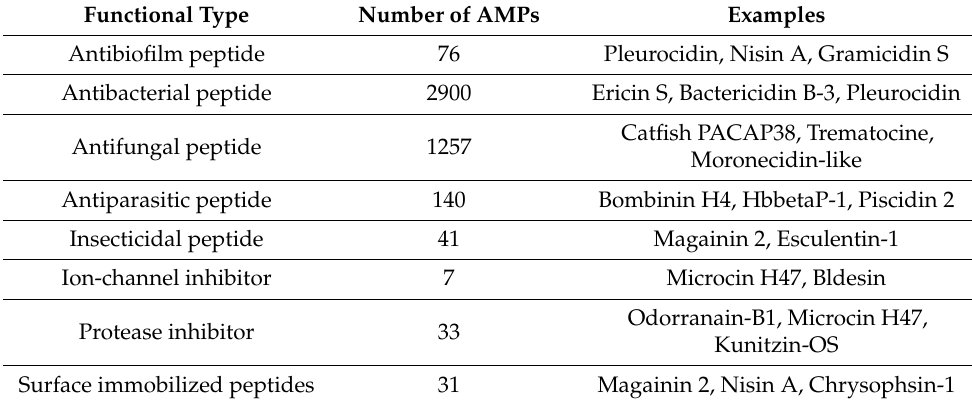
Table 1. Summary of various types of AMPs and organized from data obtained from APD3 (As on 30 June 2022)